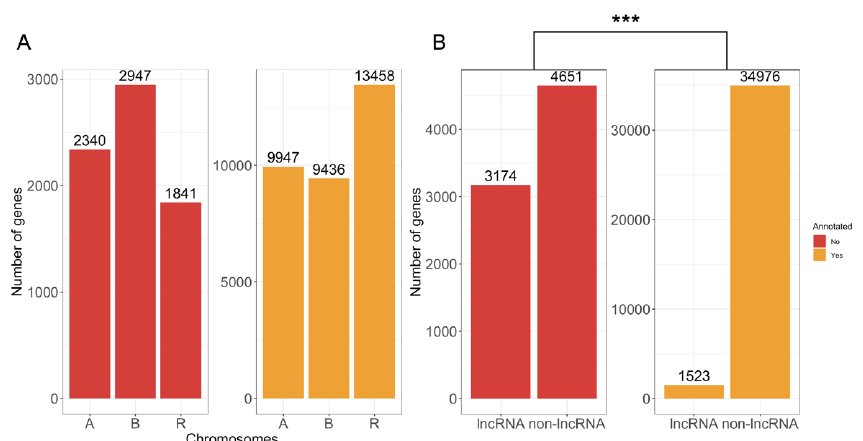
Figure 2. The characterization of previously annotated and unannotated transcripts by genome distribution and protein-coding potential. ( A ) Bar plot of the number of annotated and ‘novel’ genes located on three genomes of triticale. ( B ) The number of transcripts classified as lncRNAs expressed from annotated and novel genes. Three stars indicate the significance level ( p -value < 2.2 × 10 − 16 , Pearson’s chi-squared test with Yates’ continuity correction).